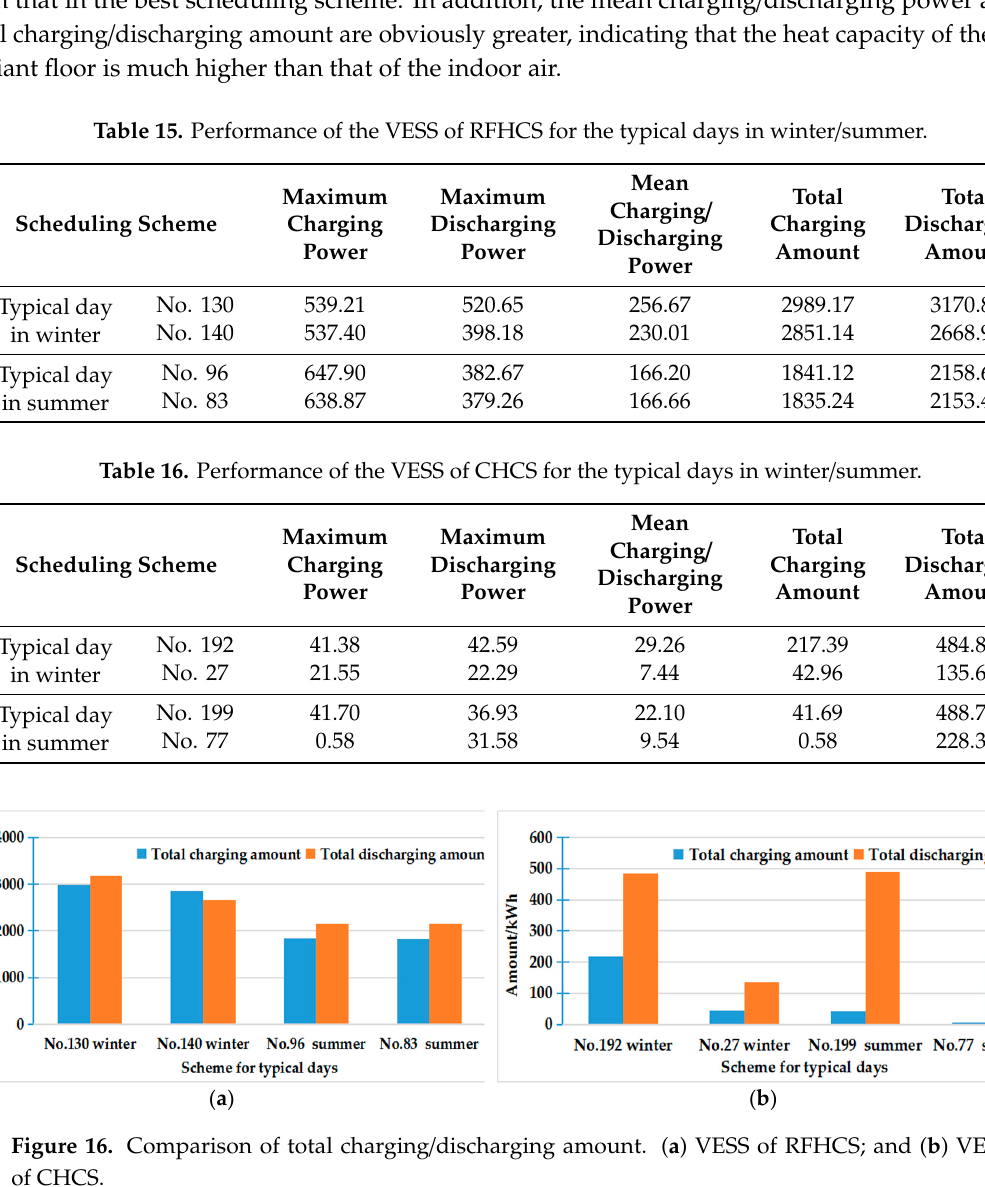
Table 16. Performance of the VESS of CHCS for the typical days in winter/summer.